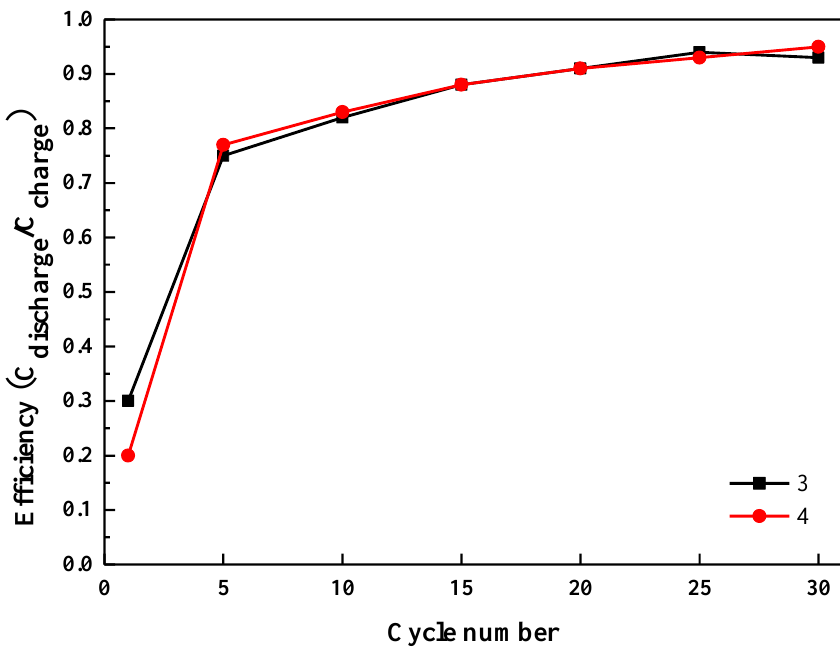
Figure 8. The coulombic efficiency vs. cycle number of the complexes 3 and 4 organic electrode.